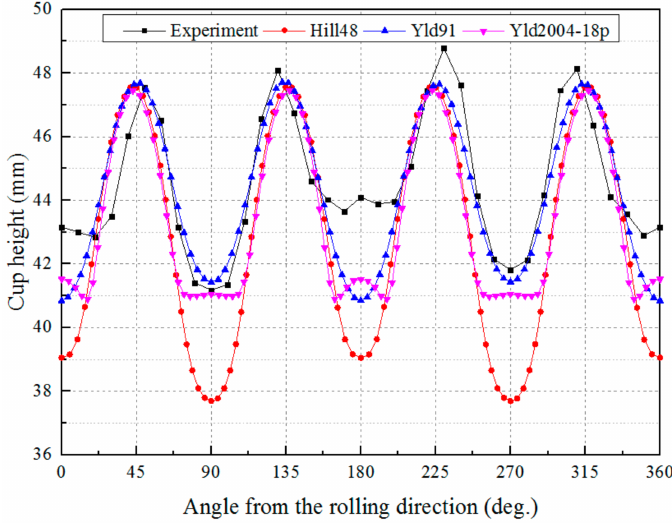
Figure 11. Cup height profile: Experimental and simulation